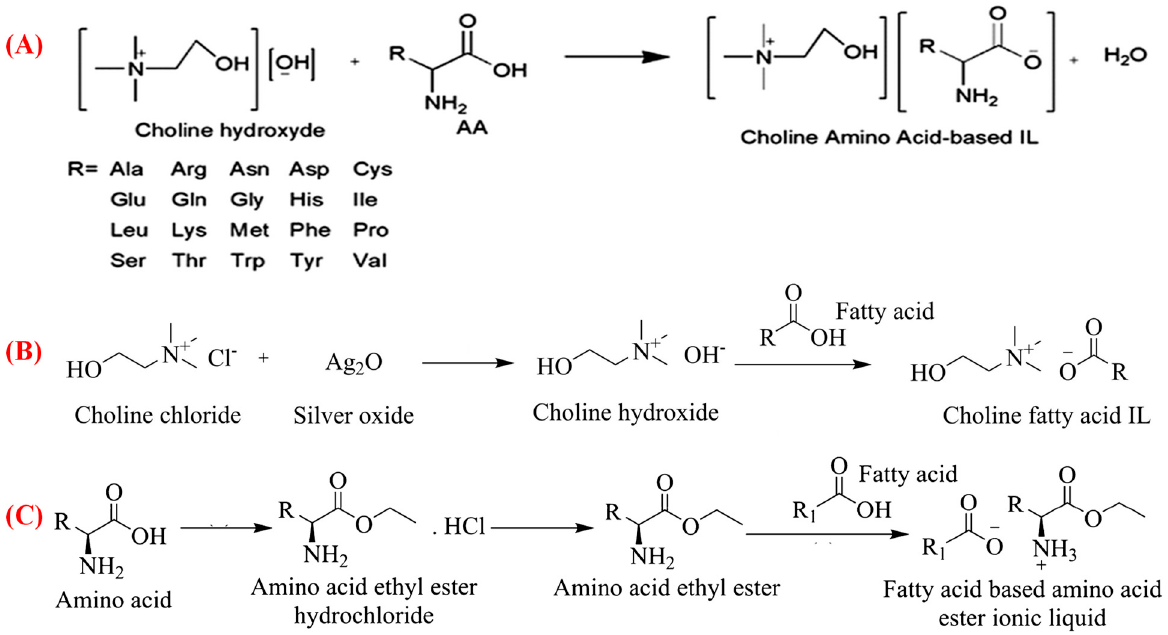
Figure 2. General synthesis procedures for ( A ) choline amino acids bio-ILs [20], ( B ) choline fatty acids bio-ILs [26], ( C ) IL-forming amino acid ester cation and amino acid fatty acid bio-ILs [27]; reproduced with permission from refs.